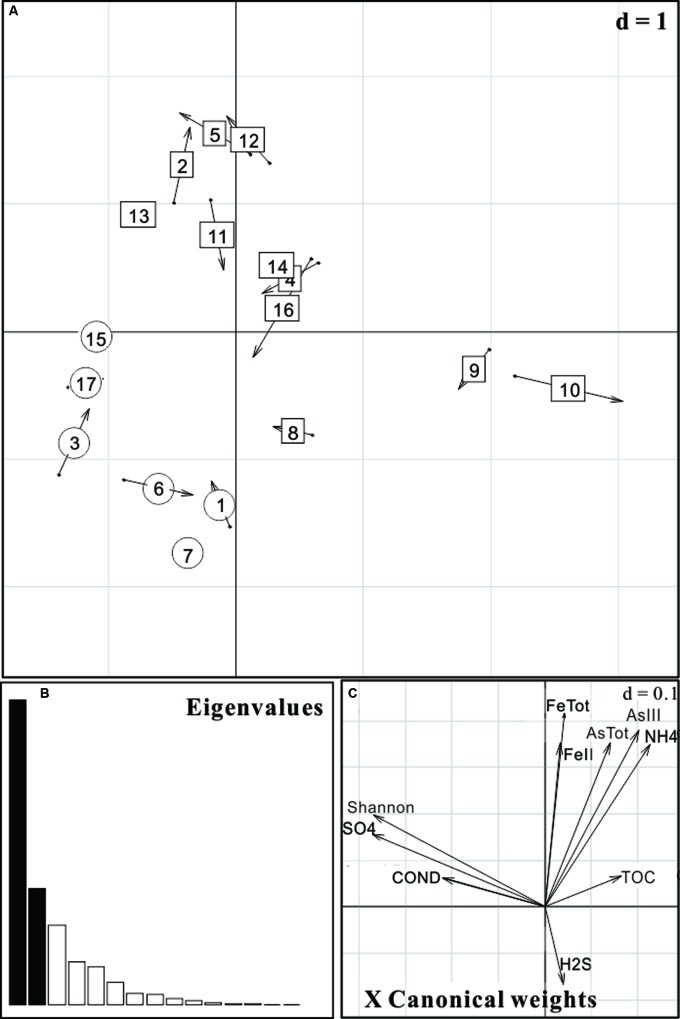
Co-inertia analysis (CIA) of microbial community and geochemical parameters of 17 groundwater samples from the Hetao Plain. (A) Samples projected on the first two axes; (B) Eigenvalues; (C) Main geochemical vectors that affect sample ordination in the CIA. As concentration was used as a factor. Circular ones represent low As samples (As < 10 μg/L) while rectangular ones represent high As samples (As > 10 μg/L).